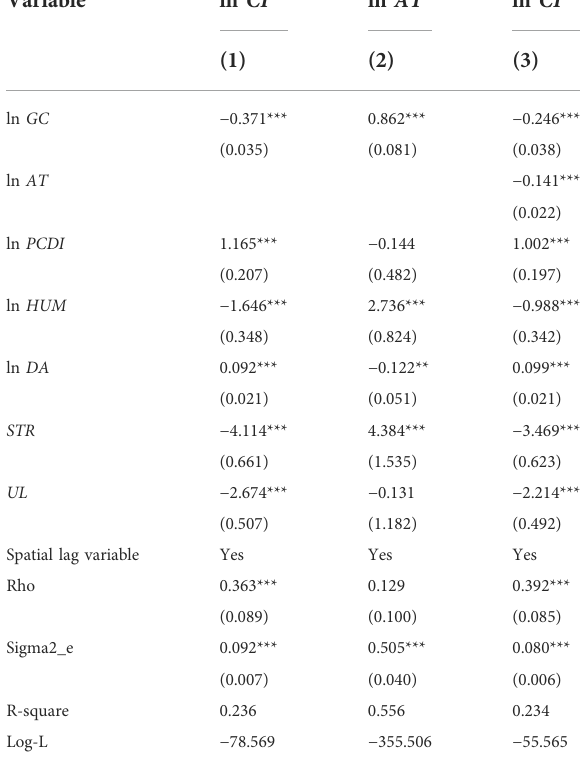
TABLE 9 Mediating effects